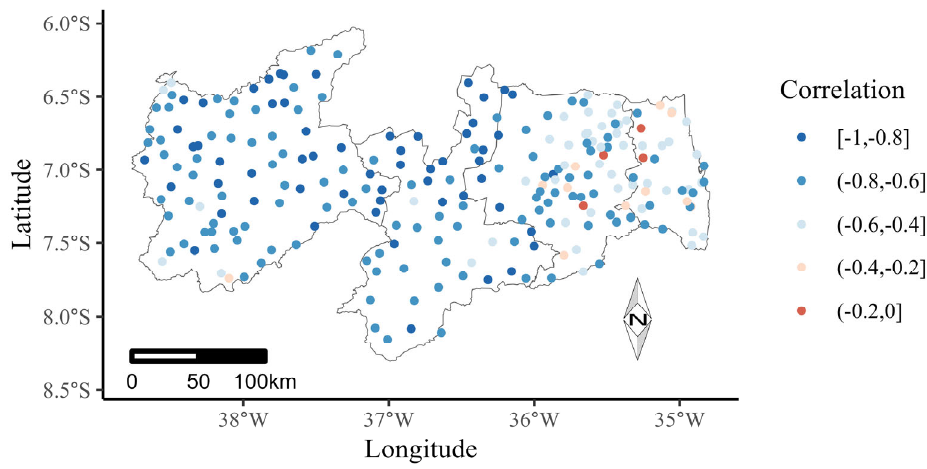
Figure 8. Spatial distribution of the Spearman correlation between the annual number of days without rain and the annual accumulated rainfall in the State of Paraíba.